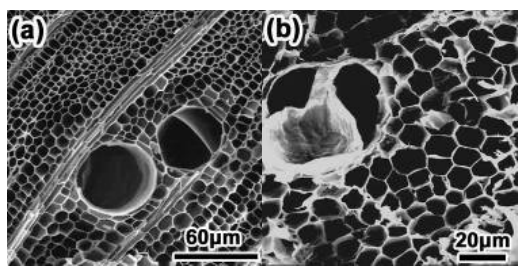
Fig. 1 SEM images of microstructures of TiC wood ce- ramics converted from wood species: (a) larch, (b) franxinus mandshurica, (c) black walnut, and (d) lauan. (e)?(h) are SEM imges showing corresponding microstructure of original wood tissues of: (e) larch, (f) franxinus mandshurica, (g) black walnut, and (h) lauan.